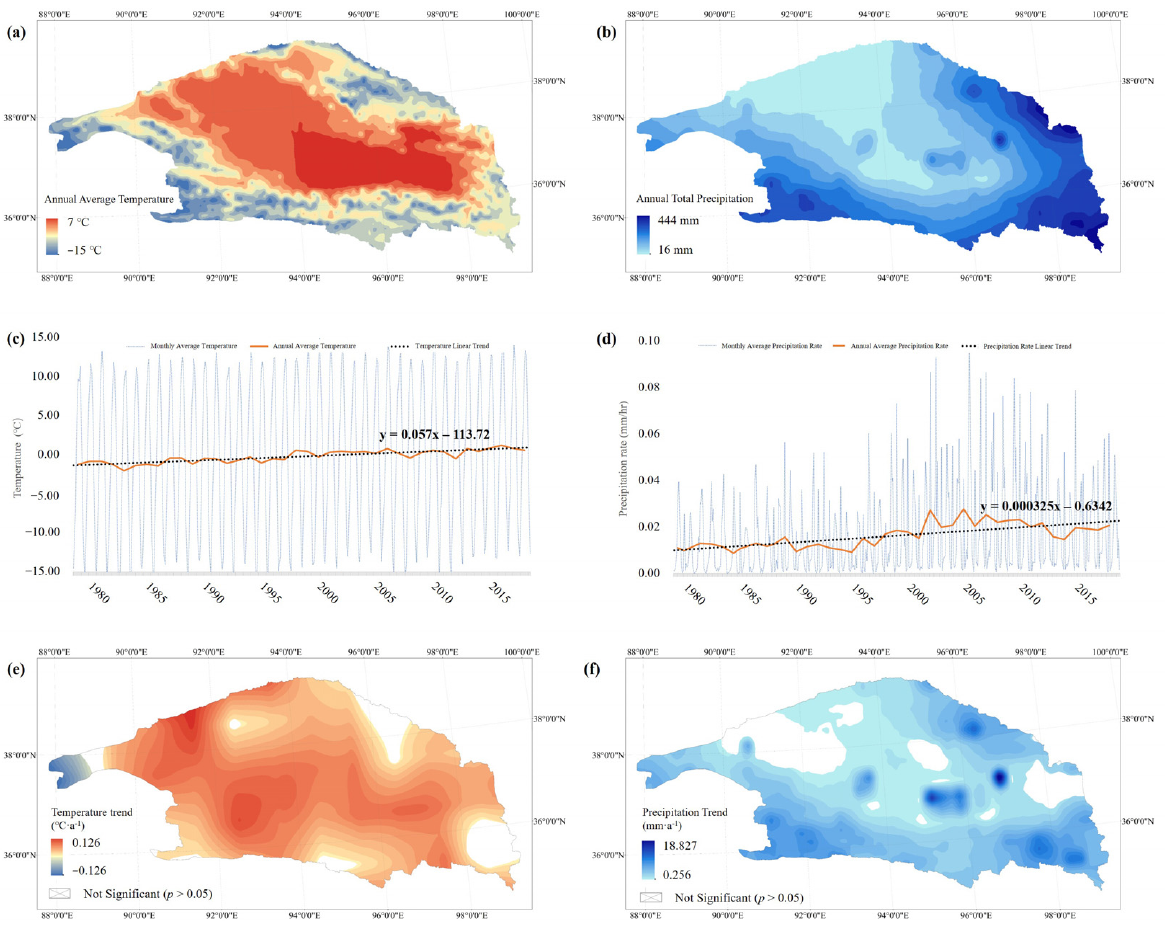
Figure 2. Temperature and precipitation in the Qaidam Basin during 1979 to 2018: ( a , b ) spatial distribution of time averages; ( c , d ) time series of spatial averages, and ( e , f ) spatial distribution of per-grid annual change.